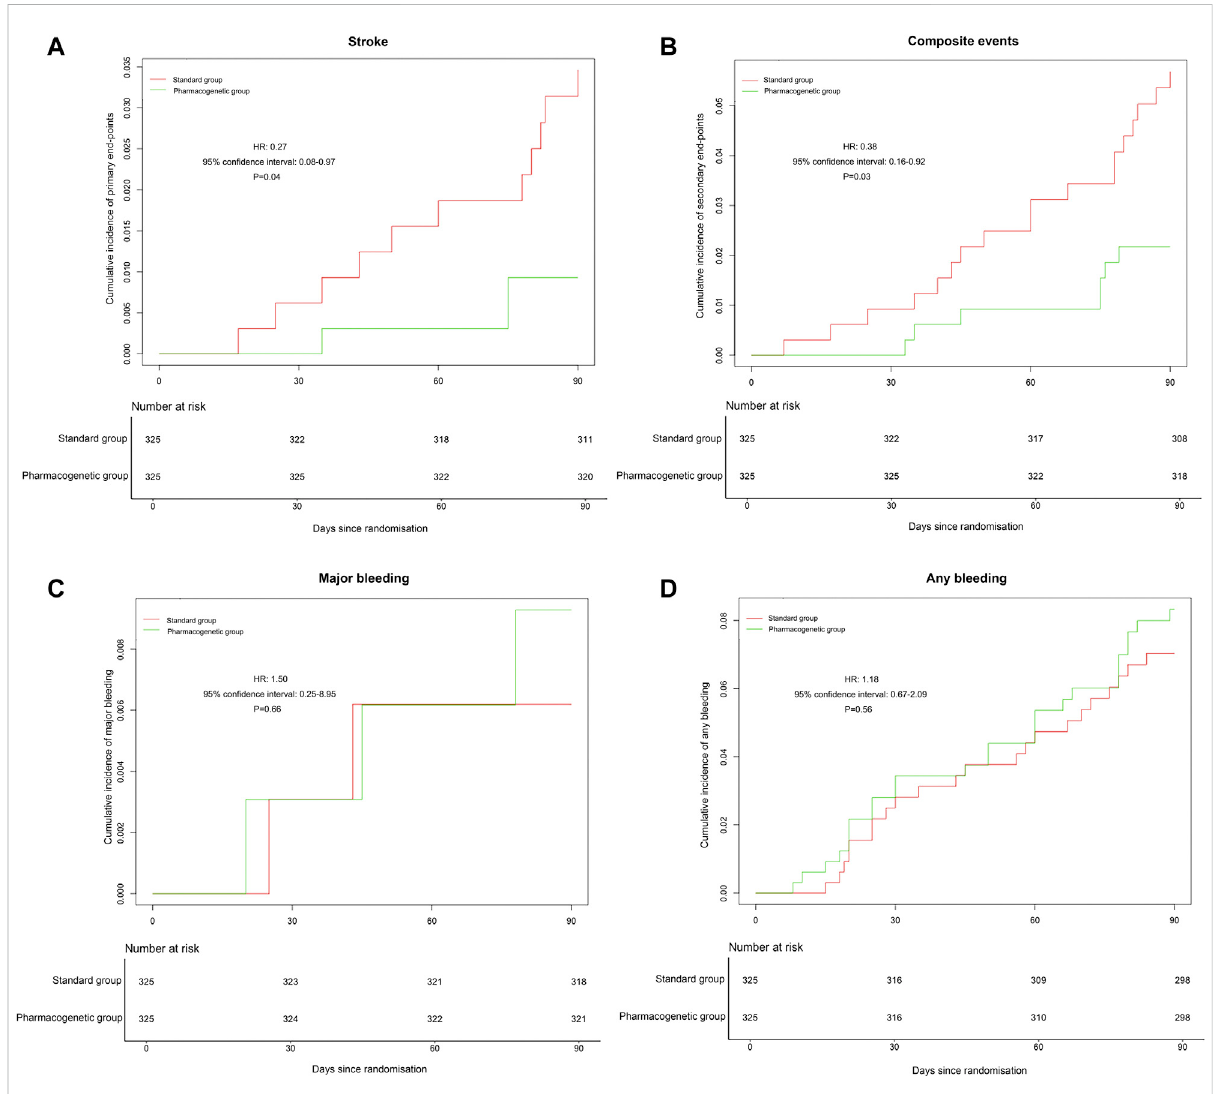
FIGURE 2 Occurrence of stroke, composite vascular, and bleeding events. (A) Cumulative incidence of the primary endpoint (stroke) in the pharmacogenetic or standard group at 90 days. (B) Cumulative incidence of the secondary endpoint (ischemic stroke, hemorrhagic stroke, TIA, myocardial infarction, vascular death, or all-cause death) in the pharmacogenetic or standard group at 90 days. (C) Cumulative incidence of the major bleeding in the pharmacogenetic or standard group at 90 days. (D) Cumulative incidence of any bleeding in the pharmacogenetic or standard group at 90 days. HR, hazard